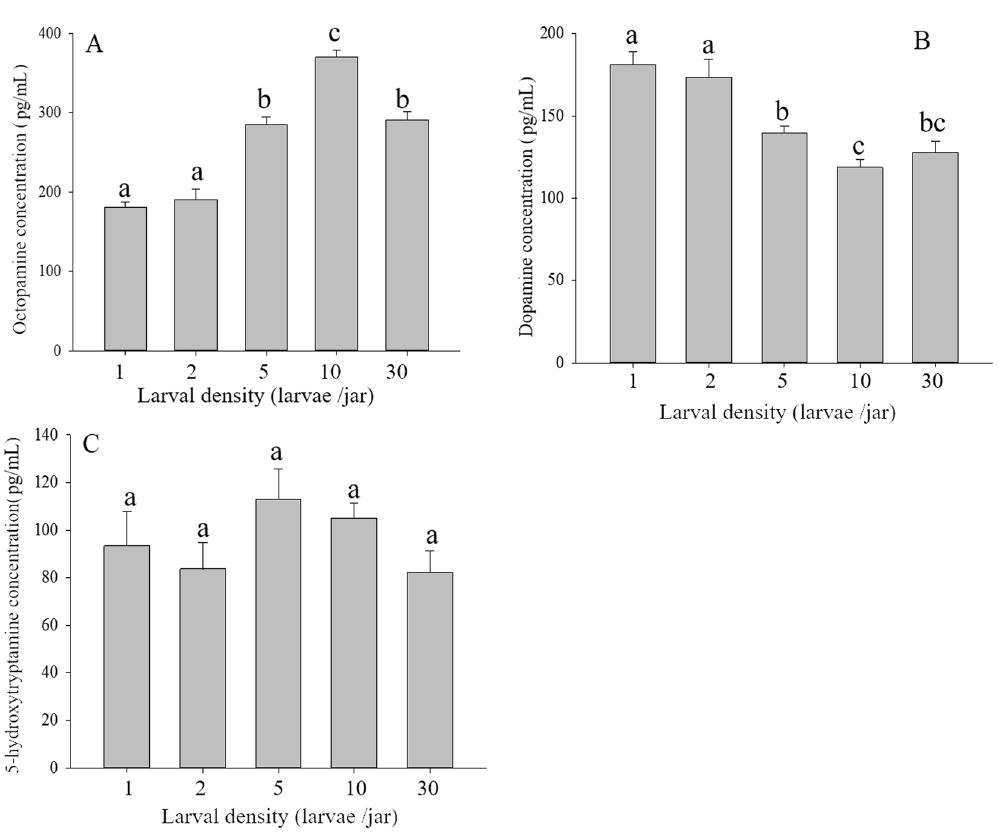
Figure 2. Effects of larval density on the levels of biogenic amines in larvae of M . separata . ( A ) Octopamine. ( B ) Dopamine. ( C ) 5-hydroxytryptamine. Values are means ± SE. Different letters indicate significant differences among the densities of 1, 2, 5, 10 and 30 larvae/jar (P <